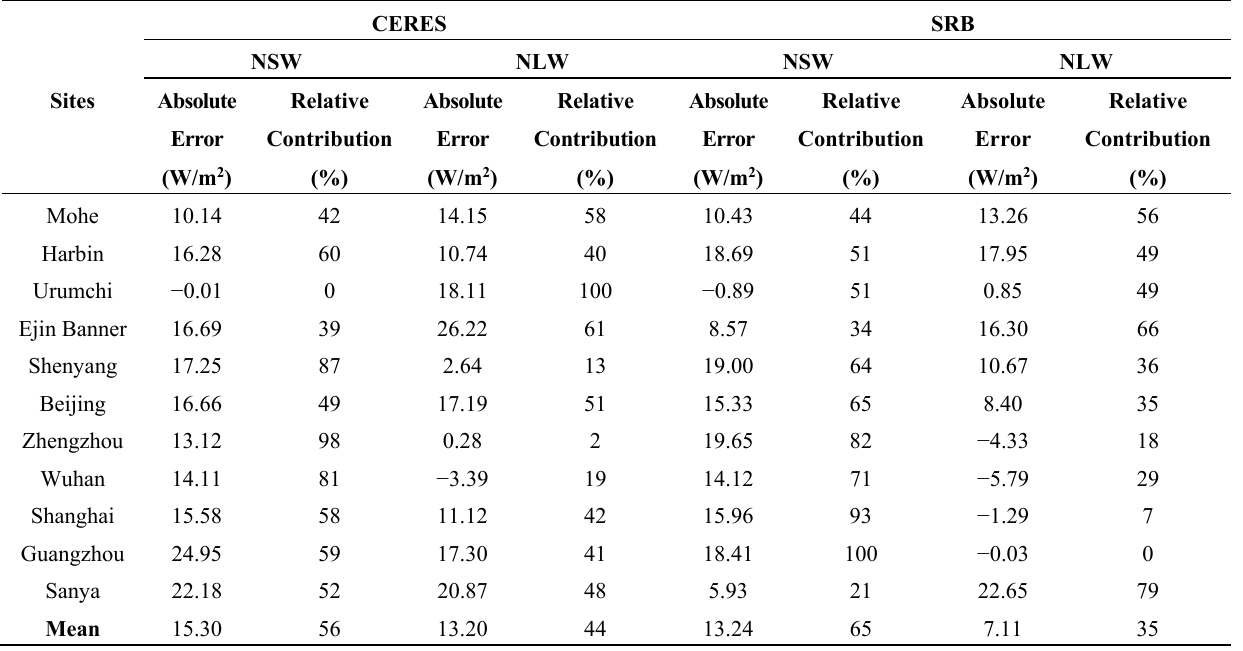
Table 1. Errors in NSW and NLW and their relative contributions to errors in surface net radiation generated from the CERES and SRB products at 11